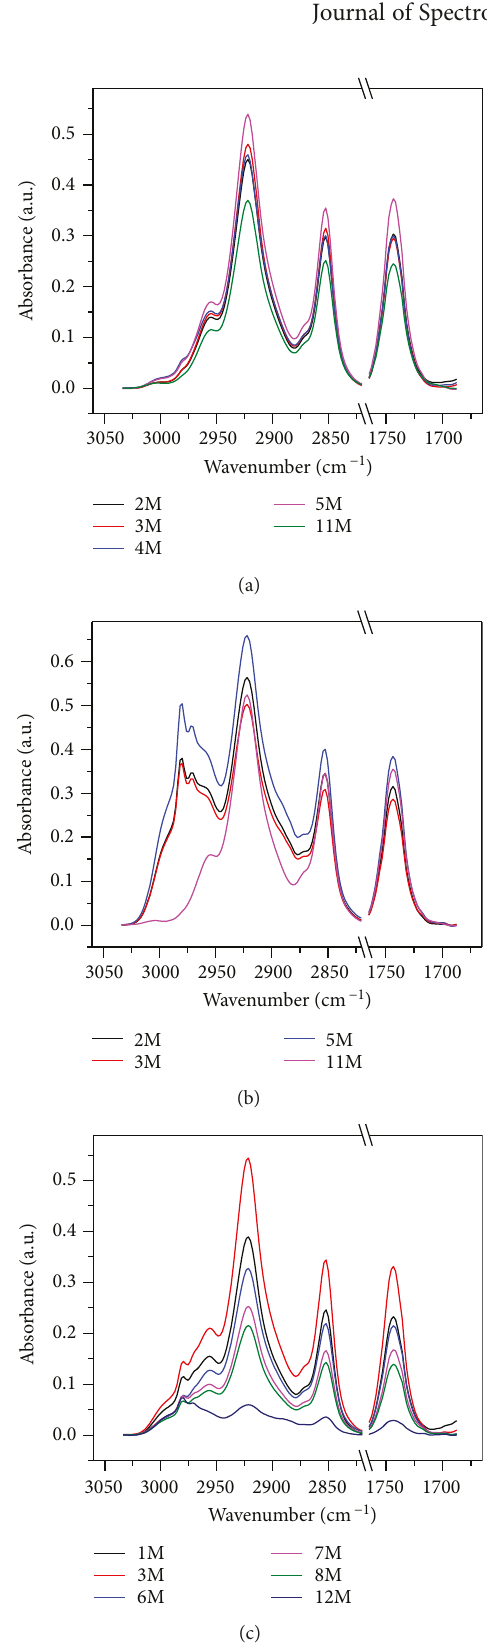
Figure 3: Fourier transform infrared spectra (3000 to 2800 cm − 1 and 1765 to 1730 cm − 1 ) of Pecorino (a), Gouda (b), and ewes ’ ripe (c) cheese samples during ripening. M: